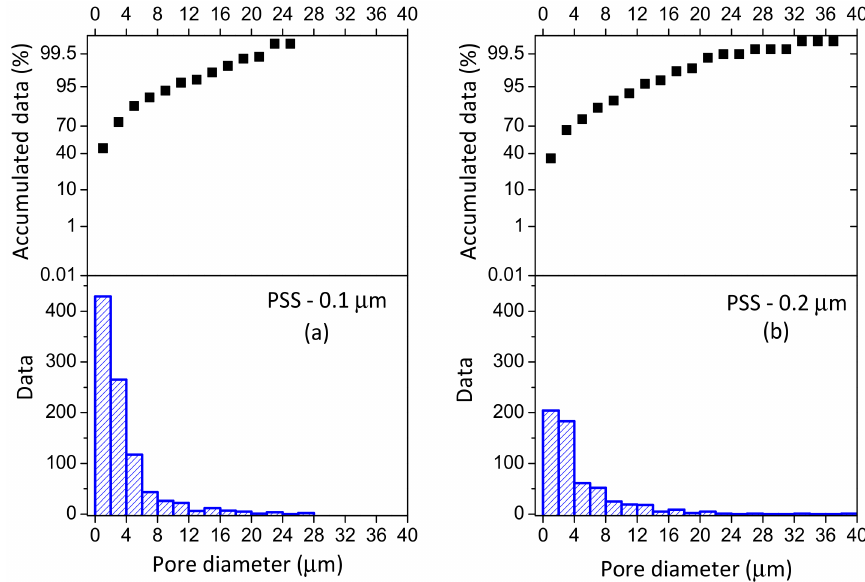
Figure 2. Pore size distribution by SEM image segmentation of PSS supports with diverse commercial media grades: ( a ) 0.1 µ m and ( b ) 0.2 µ m.